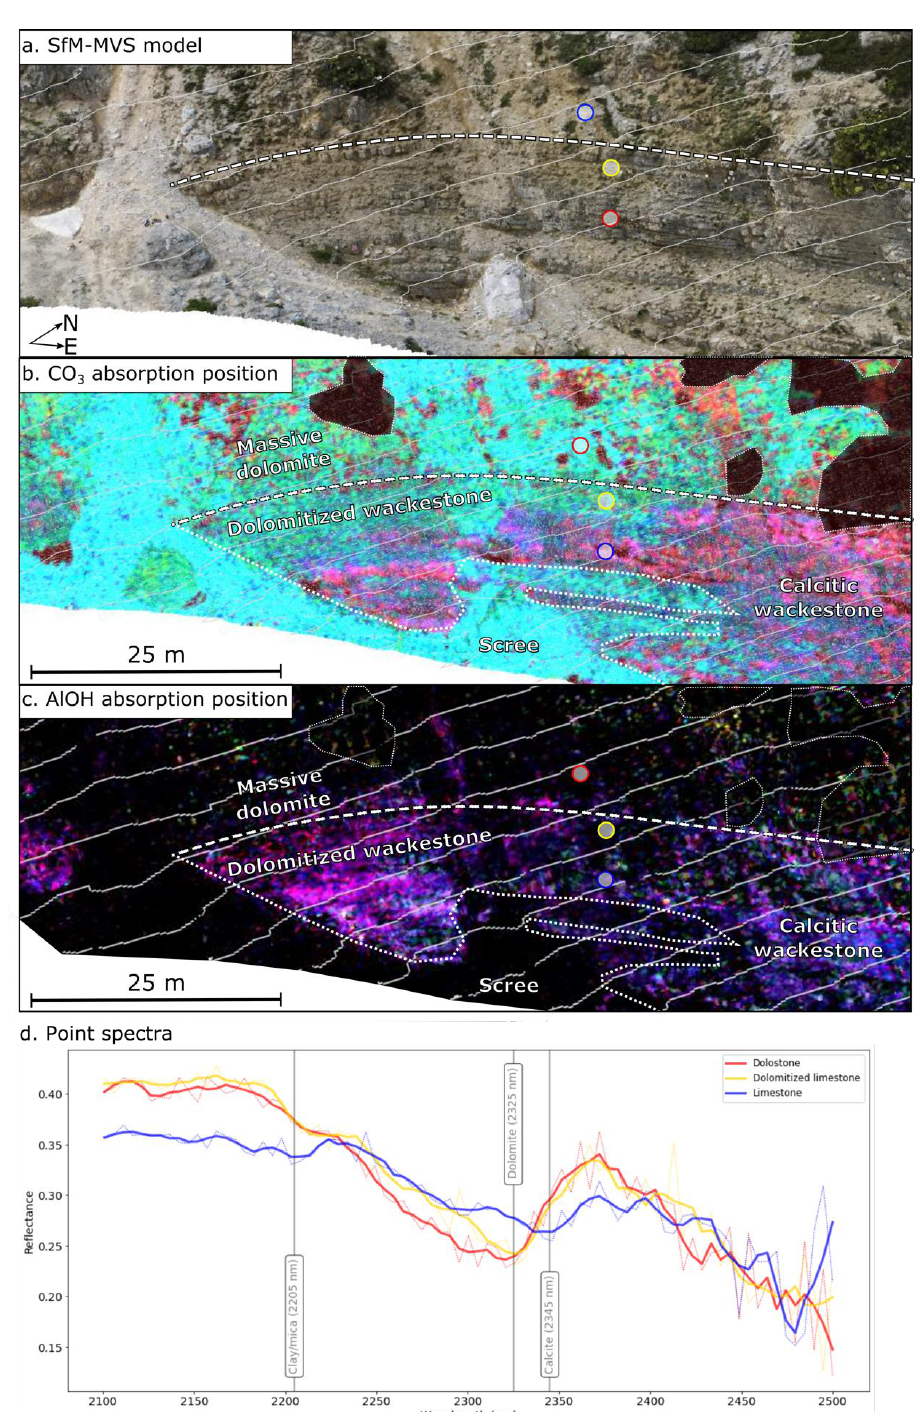
Figure 12. Close-up of the dolostone-limestone contact (dashed white line) showing the stratigraph- ically crosscutting transition zone containing dolomitised limestone in the true-colour SfM-MVS model ( a ), and carbonate ( b ) and AlOH ( c ) absorption feature minimum wavelength maps. Note that the image has been rotated to make bedding sub-horizontal; thin white lines show 3-m spaced horizontal contour lines. Example reflectance spectra ( d ) sampled from the coloured circles in ( a – c ) are plotted for reference. These spectra (dotted lines) were smoothed (solid lines) using a Savitzky – Golay filter with a window size of 7 and polynomial order of 2, to reduce noise and highlight the clear shift in absorption position from 2345 nm (calcite) to 2325 nm (dolomite). Refer to Figure 11 for the colour scales used in ( b , c